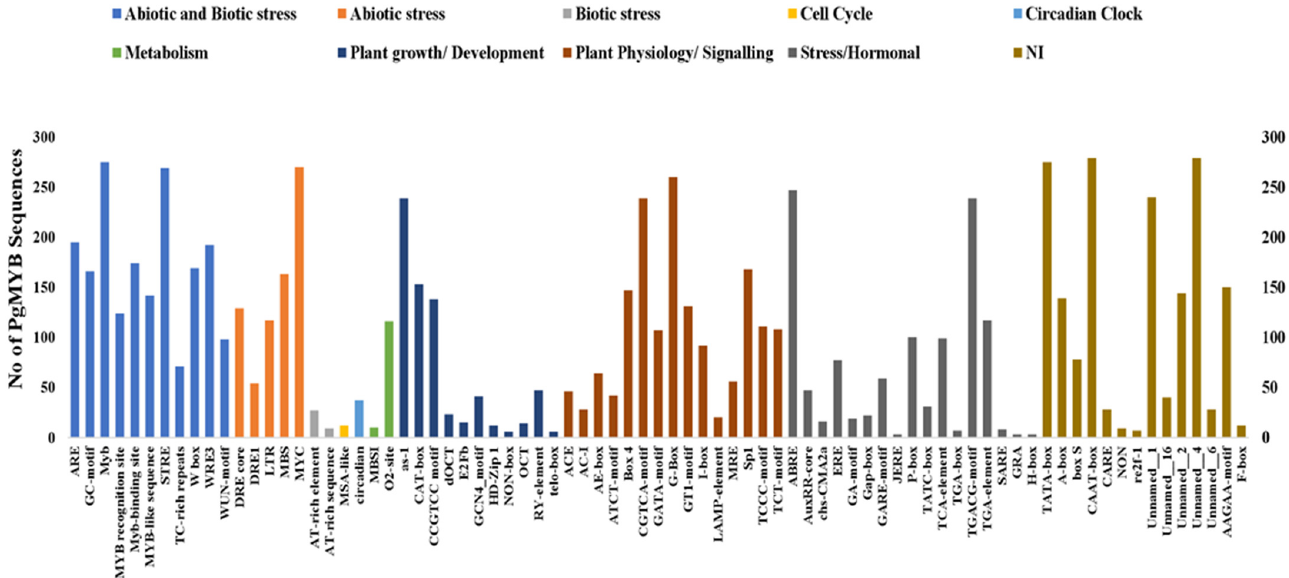
Figure 5. Presence of cis-acting regulatory elements in 2000 bp upstream region of identified PgMYBs. Color of bars indicates the group (shown in legend) to which it belongs.